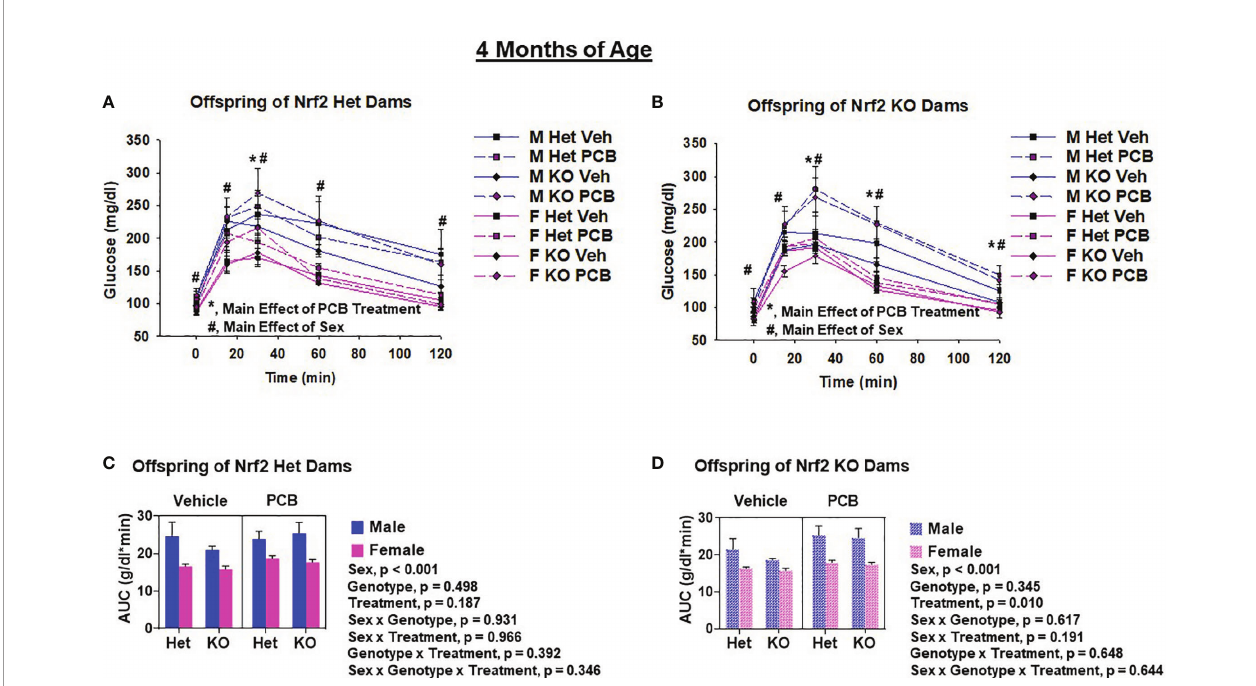
FIGURE 6 | PCB126 gestational exposure perturbs offspring glucose homeostasis pro fi les at four months of age. At four months of age, glucose was measured in Nrf2 heterozygous and knockout offspring exposed to PCB126 or vehicle during gestation in response to an oral glucose challenge (A, B) . Glucose measurements were then used to determine area under the curve (AUC; C, D ). Values reported represent the mean of litter means (n = 8 per group) ± SEM. Differences between groups were detected by three-factor ANOVA. Signi fi cance was set at a = 0.05. For simplicity, only signi fi cant main effects of PCB treatment (*) and sex (#) are shown at each time